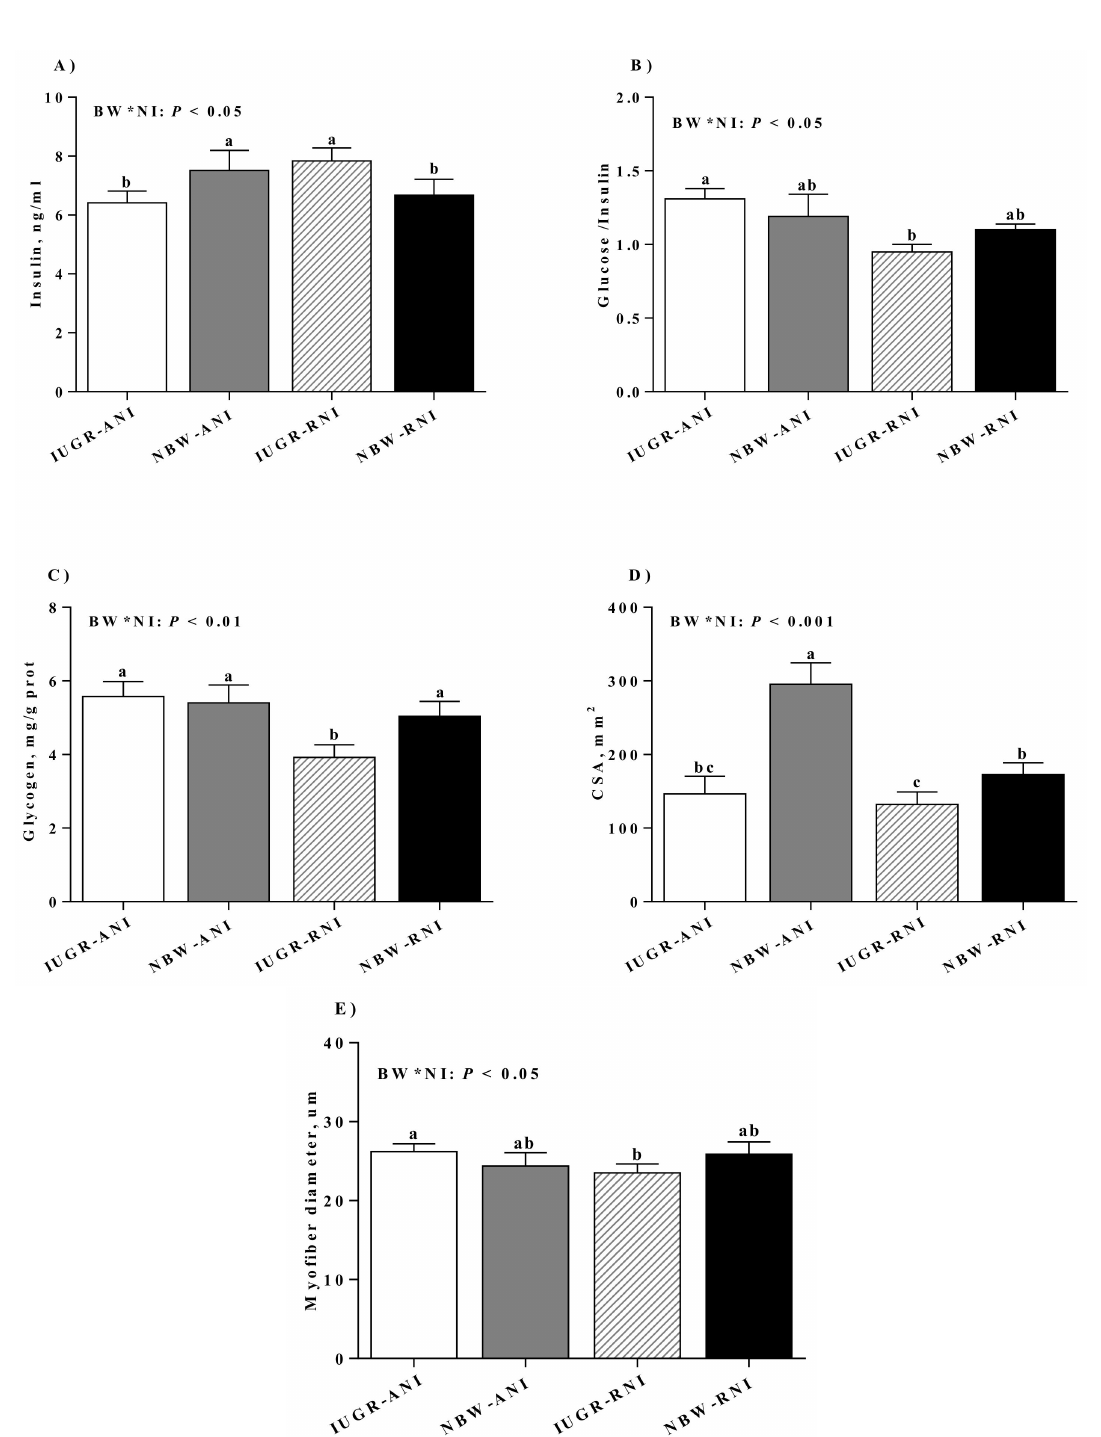
Figure 1. The interactive e ff ects of nutrient intake on ( A ) serum insulin, ( B ) the ratio of glucose to insulin, ( C ) psoas major muscular glycogen, ( D ) CSA, ( E ) myofiber diameter of intrauterine growth-retarded (IUGR), and normal-birth weight (NBW) piglets. ANI, adequate nutrient intake; RNI, restricted nutrient intake; BW, birth weight; NI, nutrient intake; CSA, cross-sectional area. a,b,c Means within a trait with di ff erent superscripts di ff er ( p <